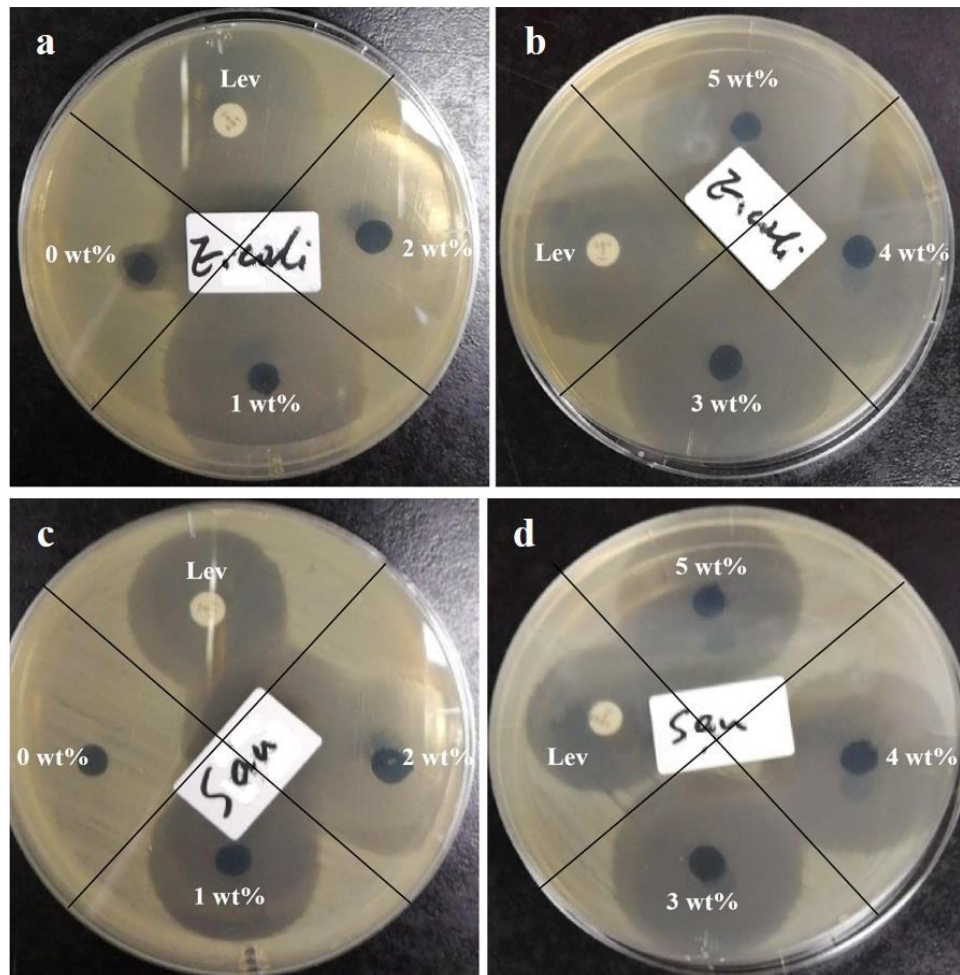
Figure 6. Antibacterial circle diagram of gelatin/genipin/levofloxacin membranes in ( a , b ) Escherichia coli ( E. coli ) and ( c , d ) S. aureus ( Sau ). Table 2. Table of inhibition zone diameters of gelatin/genipin/levofloxacin membranes against Esch- erichia coli and S. aureus .